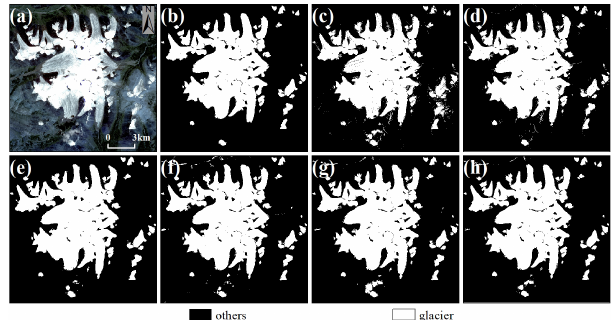
Figure 15. Demonstration of glacier extraction based on the im- age of 19 August 2020 (regional centroid coordinates of 33.11 ◦ N, 92.08 ◦ E). (a) The RGB image, (b) the ground truth, and (c) – (h) SBTM, RF, FCN, U-Net, DeepLab V3 + and Attention DeepLab V3 + with TTA, respectively.